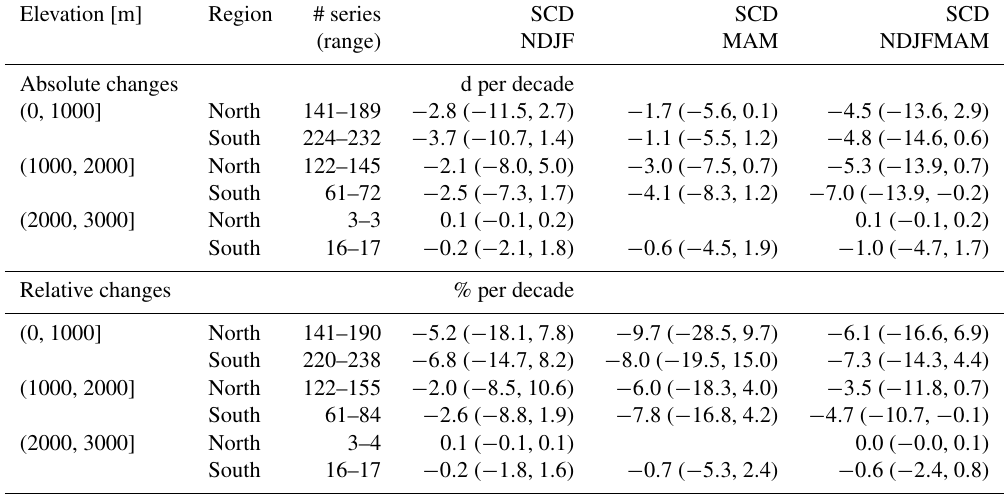
Table 4. Same as Table 3 but for seasonal snow cover duration (SCD), where absolute trends are and in days per decade (d per decade). Elevation [m] Region # series SCD SCD